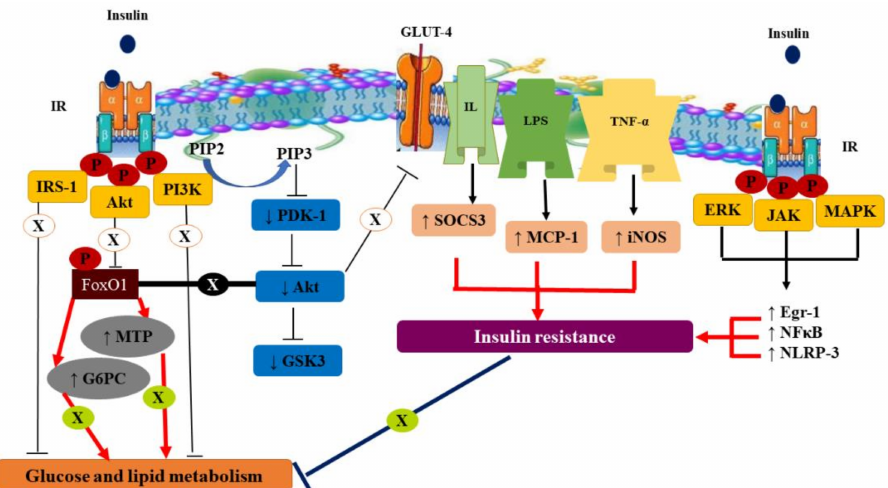
Figure 1. Molecular mechanism of insulin resistance. Akt: protein kinase B, IRS-1: insulin receptor substrate-1, PI3K: phosphatidyl inositol-3-kinase, PIP2: phosphatidylinositol 4,5-bisphosphate, PIP3: phosphatidylinositol 3,4,5-trisphosphate, PDK-1: phosphoinositide-dependent protein kinase 1, GSK3: glycogen synthase kinase 3, GLUT-4: glucose transporter-4, IL: interleukin, SOCS3: suppressor of the cytokine signaling, LPS: lipopolysaccharides, MCP-1: monocyte chemoattractant protein-1, TNF- α : tumor necrosis factor-alpha, iNOS: inducible nitric oxide synthase, ERK: extracellular signal- related kinase, JAK: Janus kinase-2, MAPK: mitogen-activated protein kinase, Egr-1: early growth response-1, NF- κ B: nuclear factor-kappa B, NLRP-3: NOD-like receptor protein-3, FoxO1: forkhead box O1, MTP: microsomal triacylglycerol transfer protein, G6PC: glucose-6-phosphatase catalytic subunit